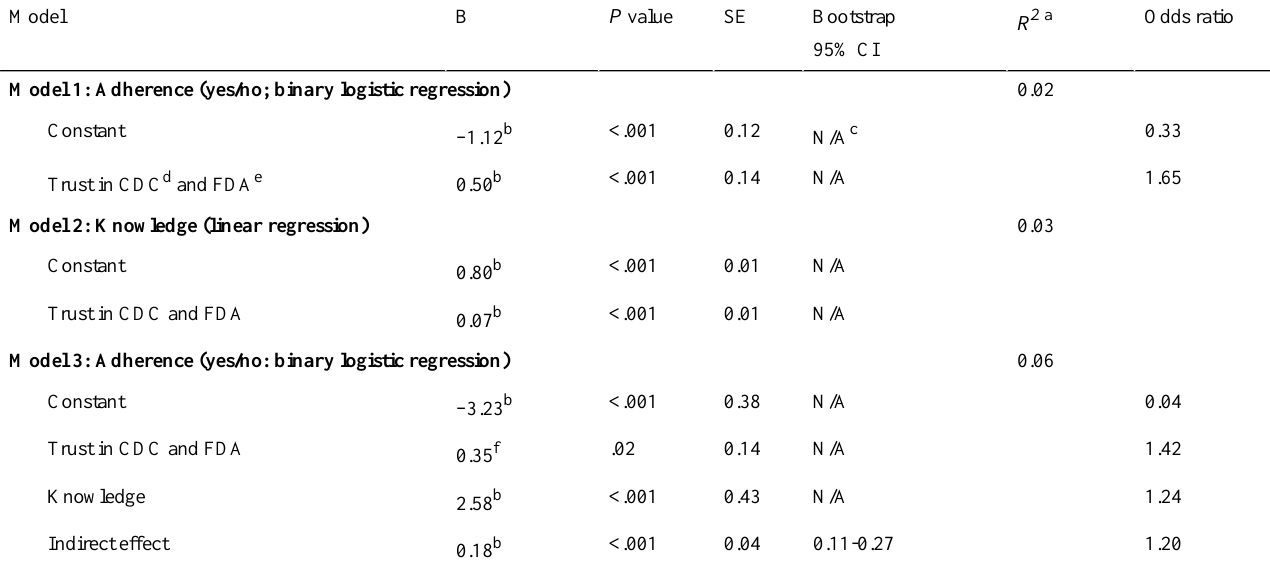
Table 7. Results of the mediation analysis of trust in the CDC and FDA (X), knowledge about COVID-19 (M), and adherence to social distancing behaviors (Y). Null prediction for adherence to all social distancing behavior was 32%; reported coefficients are